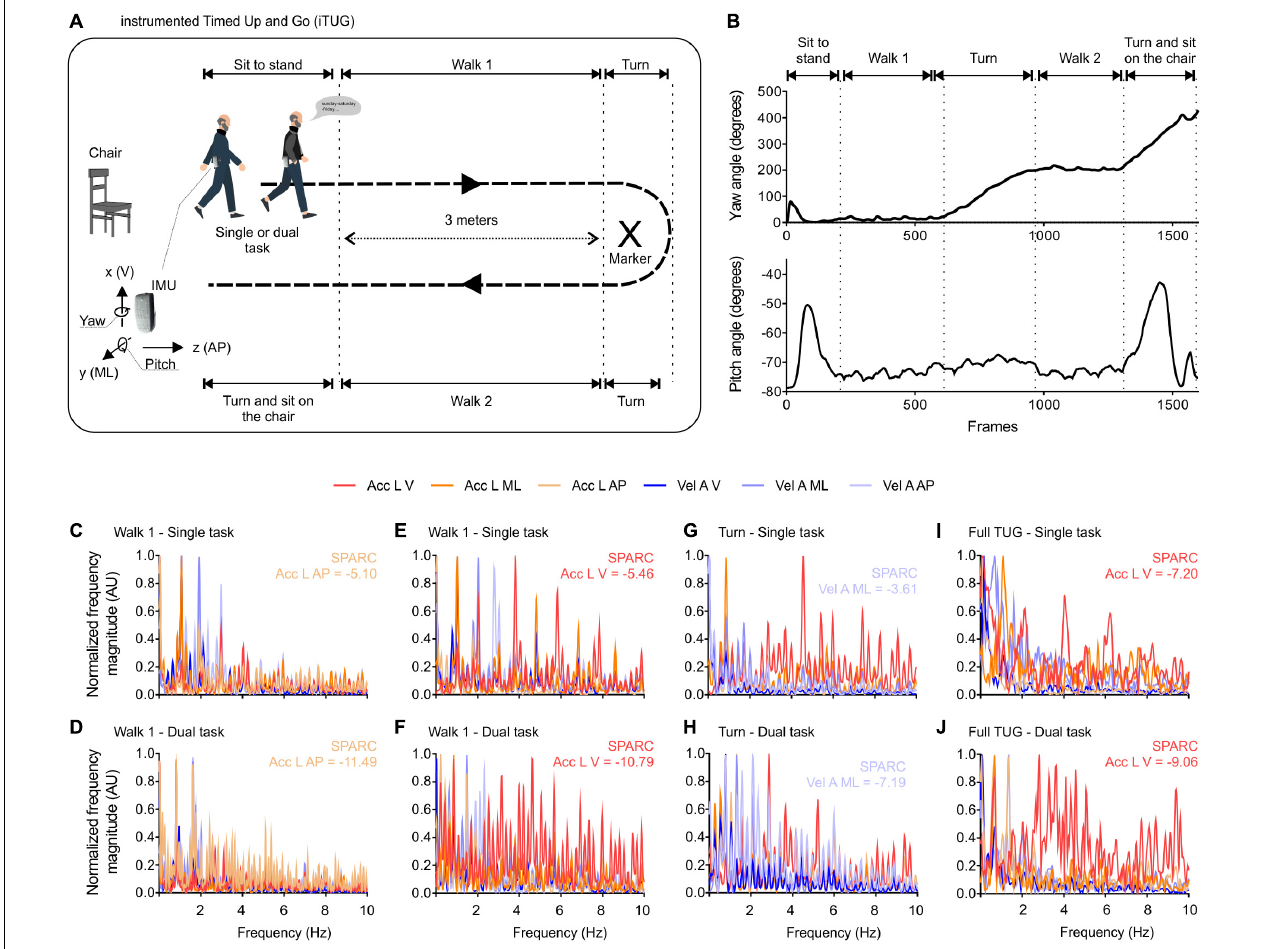
FIGURE 1 | Instrumented timed up-and-go (iTUG) test and mobility smoothness (SPARC). (A) The TUG test was performed in single or dual task conditions, participants wore an inertial measurement unit (IMU) attached to the waist. The IMU measured linear accelerations (Acc L), angular velocities (Vel A), and angles in the three axes of movement. (B) TUG phases were identified using yaw and pitch angles. The full TUG and the following phases of the TUG were analyzed: sit-to-stand, walk 1, turn, walk 2, turn, and turn-to-sit (also depicted by arrows in A ). (C–J) Representative spectral profiles used for the calculation of SPARC, note how some participants showed abundant frequency spectra above 5 Hz (expected to contain most of the frequencies components during steady-state walking). V: ventral; ML: mediolateral; AP: anteroposterior; SPARC: spectral arc length; Acc L: linear acceleration; Vel A: angular velocity; AU: adimensional unit; TUG: timed up-and-go; IMU: inertial measurement